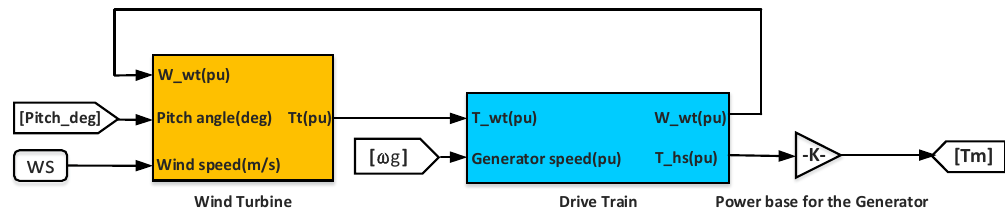
Figure 9. Block diagram of the wind turbine and mechanical drive shaft model. The symbols in this figure, W_wt , Pitch_deg , WS , Tt , T_wt , ωg , T_hs and Tm denote the wind turbine speed, blade pitch angle, wind speed, torque of the mechanical drive shaft, wind turbine torque, generator speed, torque transmitted through the shaft, and torque at the input of the generator, respectively.